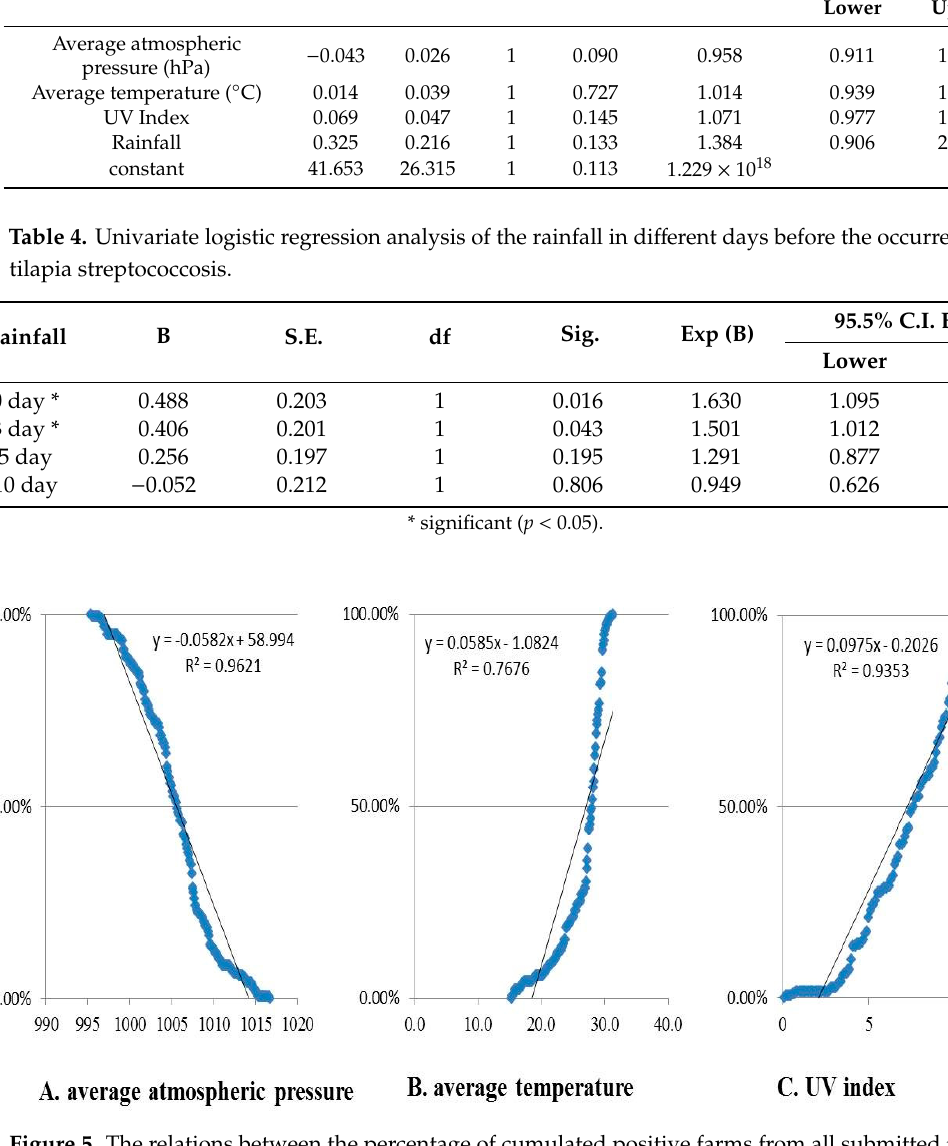
Table 4. Univariate logistic regression analysis of the rainfall in different days before the occurrence of tilapia streptococcosis.